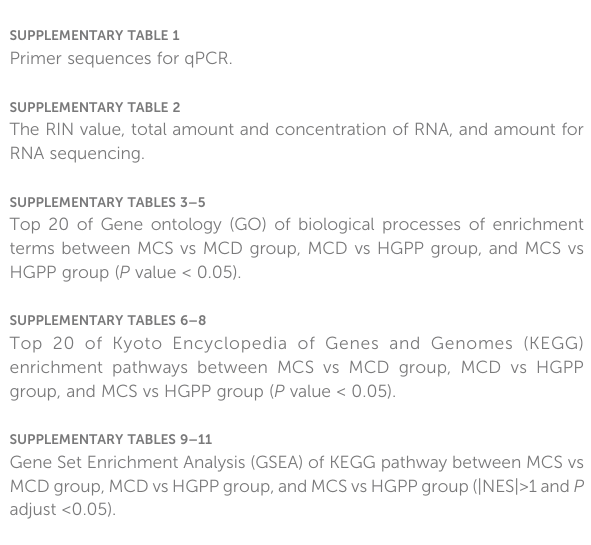
SUPPLEMENTARY FIGURE 3 Gene expression pro fi les among MCS, MCD, and HGPP groups. SUPPLEMENTARY FIGURE 4 The western blotting analysis of Caspase-1/ b -actin and Pro-caspase-1/ b -actin. SUPPLEMENTARY TABLE 1 Primer sequences for qPCR. SUPPLEMENTARY TABLE 2 The RIN value, total amount and concentration of RNA, and amount for RNA sequencing.